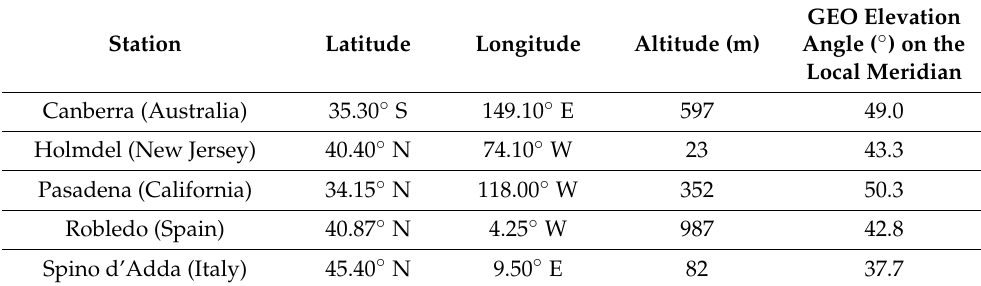
Table 1. Reference